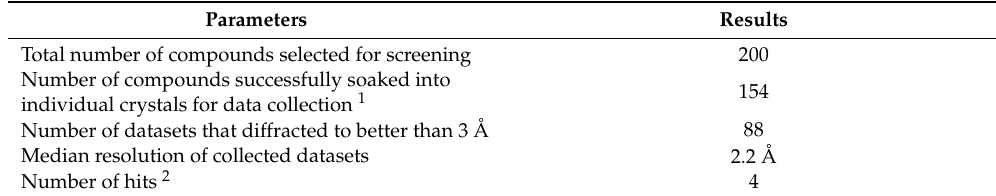
Table 1. Statistics of the FBS-X screening experiment.